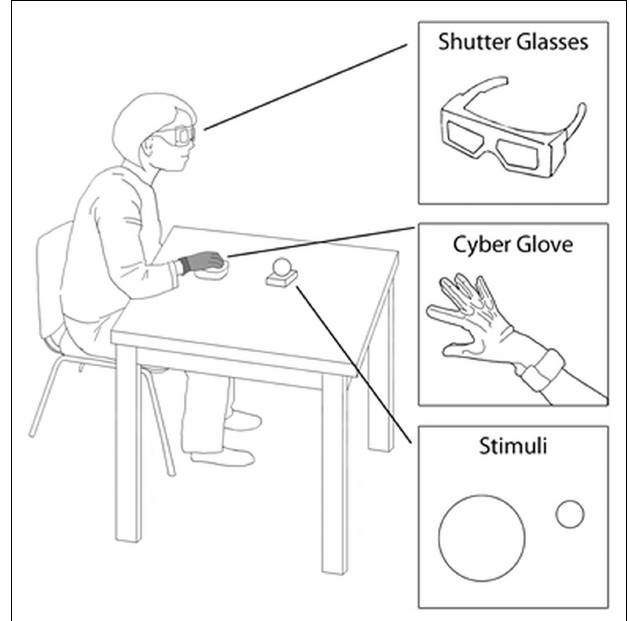
FIGURE 1 | Graphical representation of the experimental set-up . Legends indicate the relevant